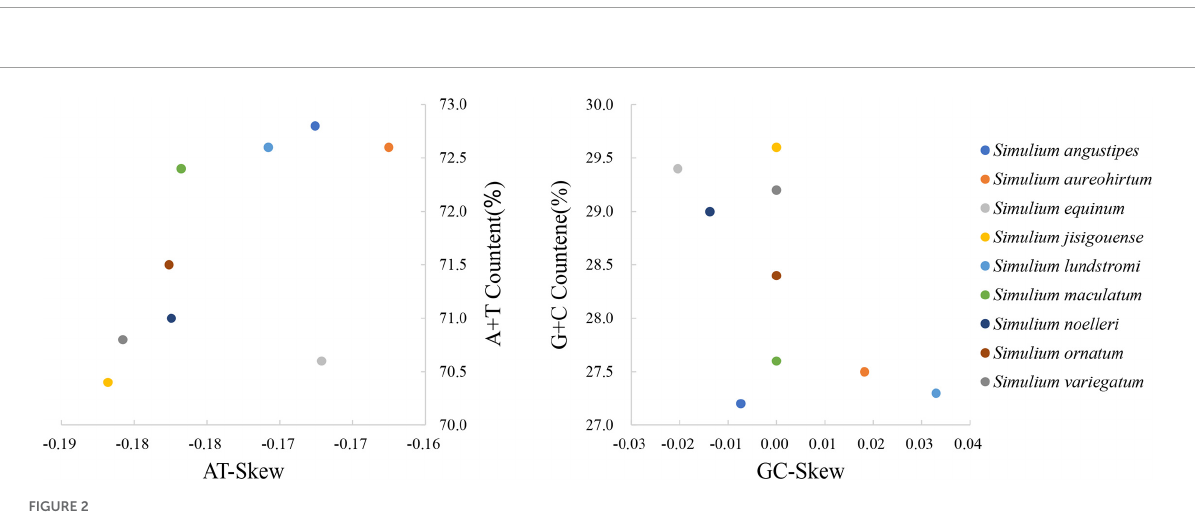
FIGURE1 Mitochondrial maps of Simulium jisigouense . The tRNAs, rRNAs, and protein-coding genes (PCGs) are denoted by the color blocks. Genes outside the map are transcribed clockwise, whereas those inside are transcribed counter-clockwise.